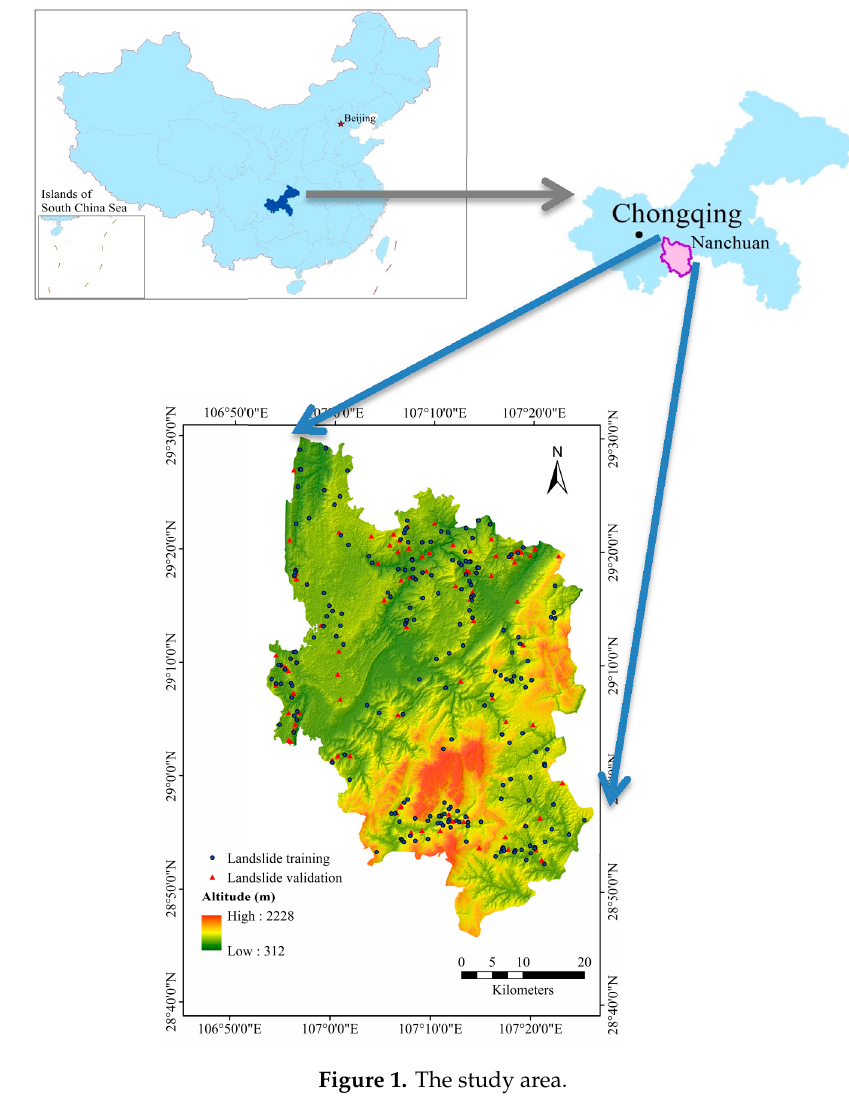
Figure 1. The study area.